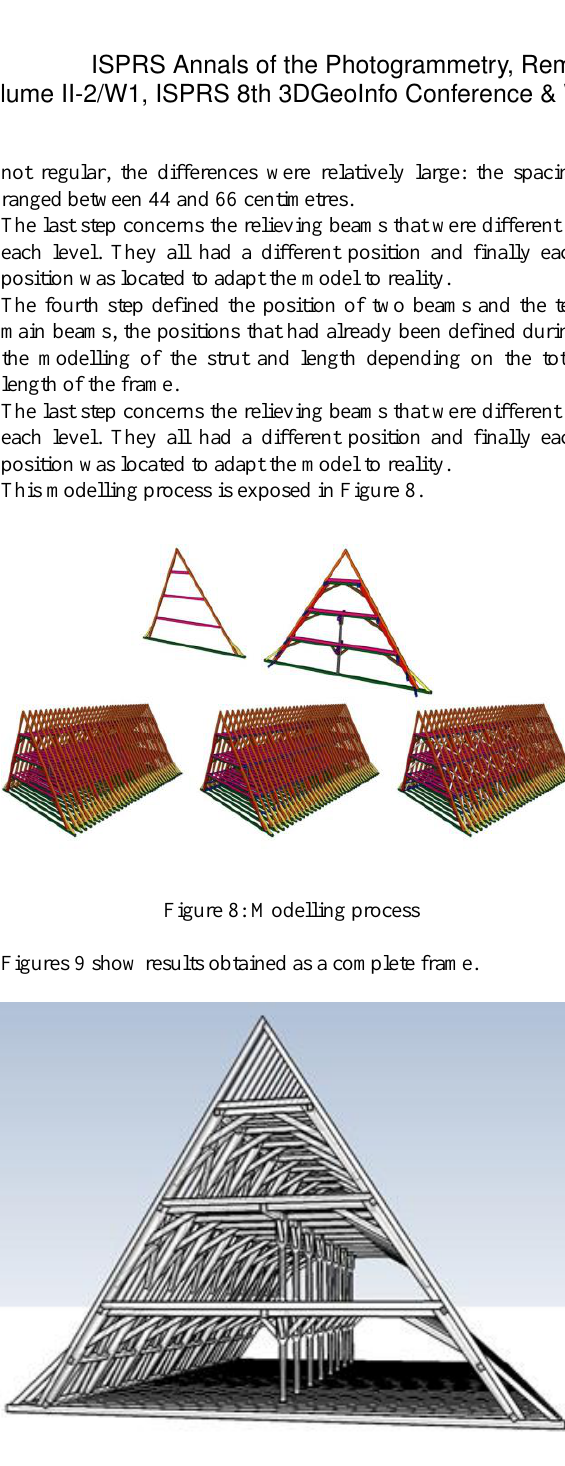
Figure 9a: Model of full framework